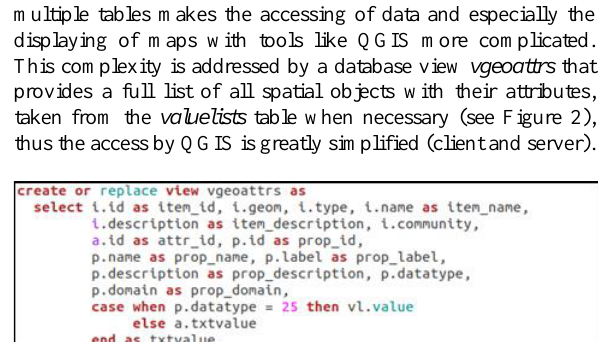
 Initial set up of an import representation using cadastral data from ALKIS data and field data taken from Excel sheets or imported from spatial data collection tools like QField  Load the generic representation from the database schema set up in the first step using SQL scripts, typically run via the PosgreSQL command line tool pgsql  Access the generic representation from QGIS, the web interface (using QGIS Server and Lizmap), and the FMS accounting application